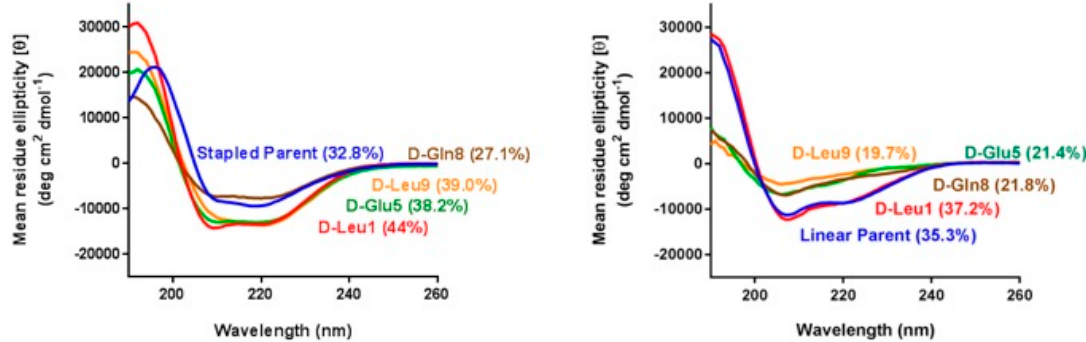
Figure 4. Circular dichroism spectra of stapled peptides bearing D -amino acid substitutions (left panel) and their corresponding linear counterparts (right panel). The table gives the sequences of the parent peptides.